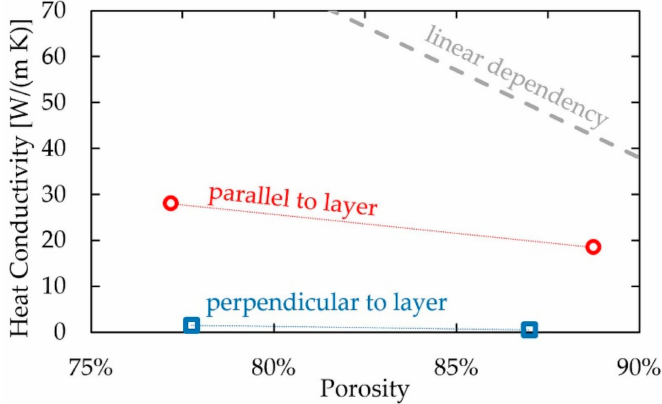
Figure 7. Heat conductivity along two different directions of an expanded sheet metal structure. The grey dotted line indicates a theoretical linear dependency of the heat conductivity on the